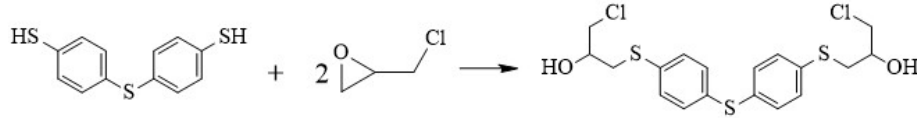
Figure 1. Synthesis of DGETDBT (step 1).